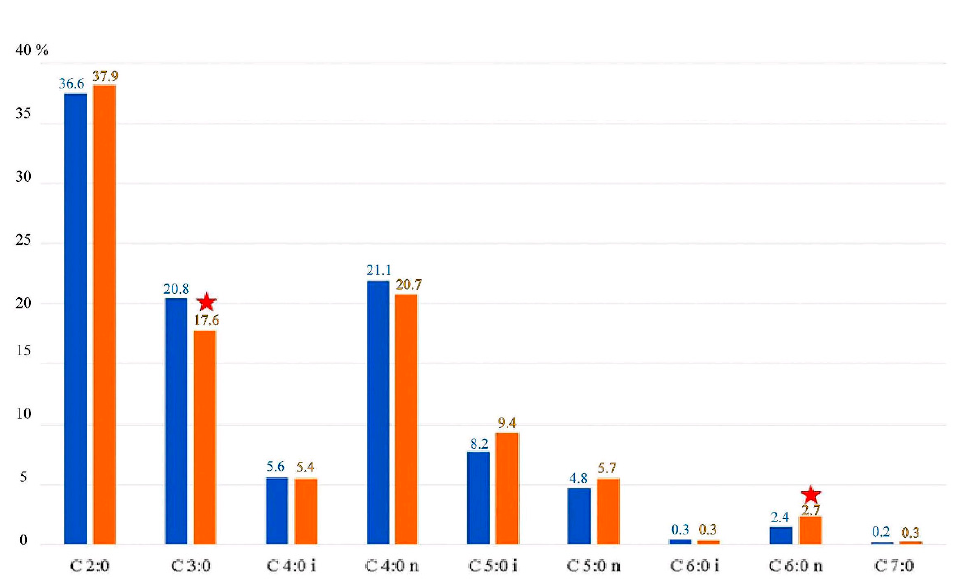
Figure 1. SCFAs in the experimental group (OW) and control group (CG) expressed as a percentage. OW—blue color; CG—orange color; (cid:70) indicates statistically significant differences ( p < 0.05).